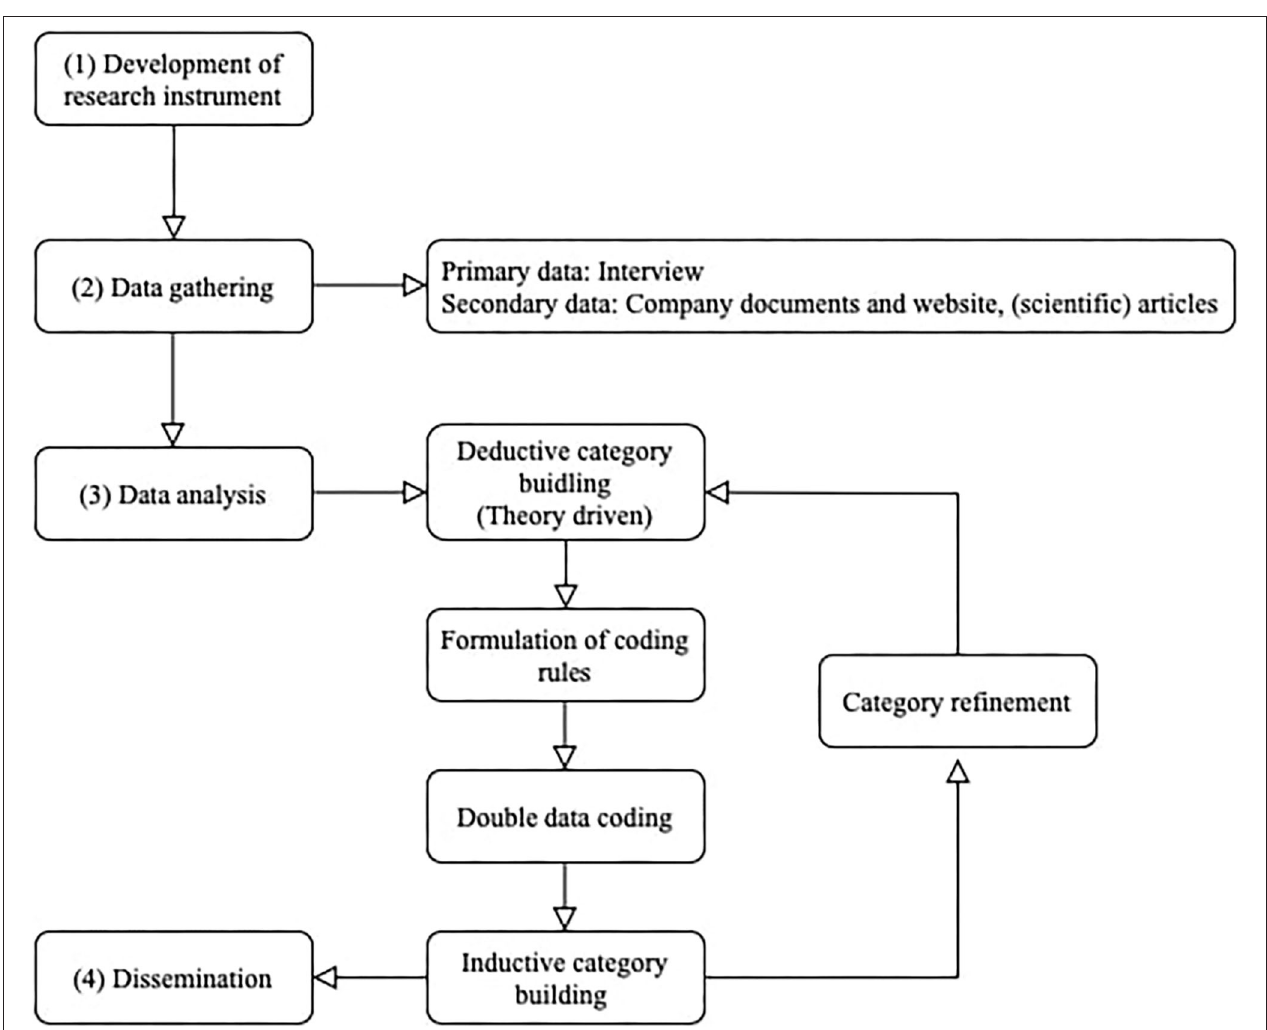
FIGURE 1 | Applied research process (based on Stuart et al.,